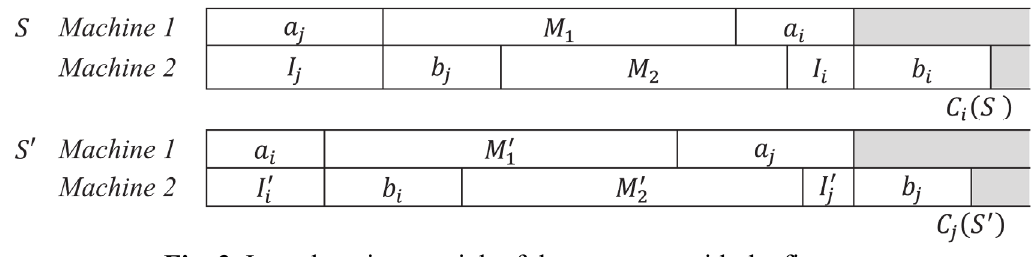
Fig. 3. Interchanging any job of the sequence with the first